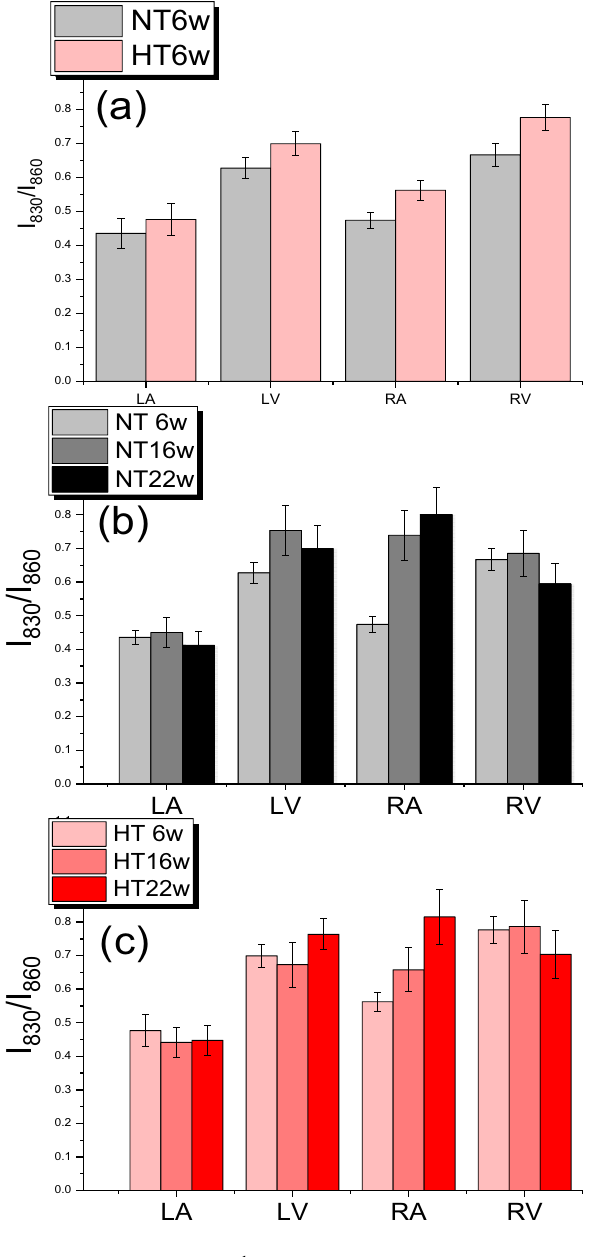
Figure 4. ( a ) 830/860 cm −1 intensity ratio (I 830 /I 860 ) obtained from Raman spectra of six-week normotensive and hypertensive rats. I 830 /I 860 obtained from Raman spectra of ( b ) normotensive and ( c ) hypertensive rats at six- (6w), 16- (16w), and 22-weeks (22w) of age. NT indicates normotensive Dahl/SS rat; HT, hypertensive Dahl/SS rat; LV, left ventricle; RV, right ventricle; LA, left atrium; and RA, right